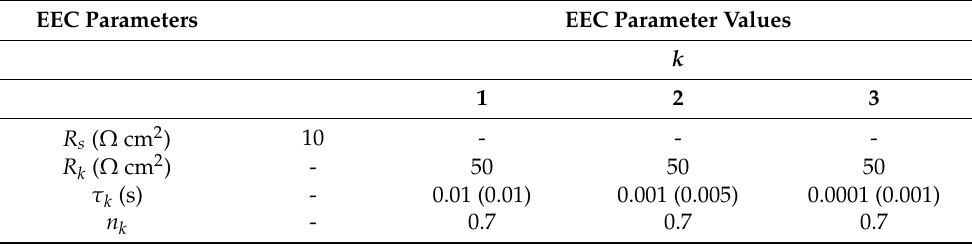
Table 2. EEC parameter values used to compute the synthetic ZARC data (10) in this work. Values in parentheses present τ values used to prepare ZARC data with a more corrupted local